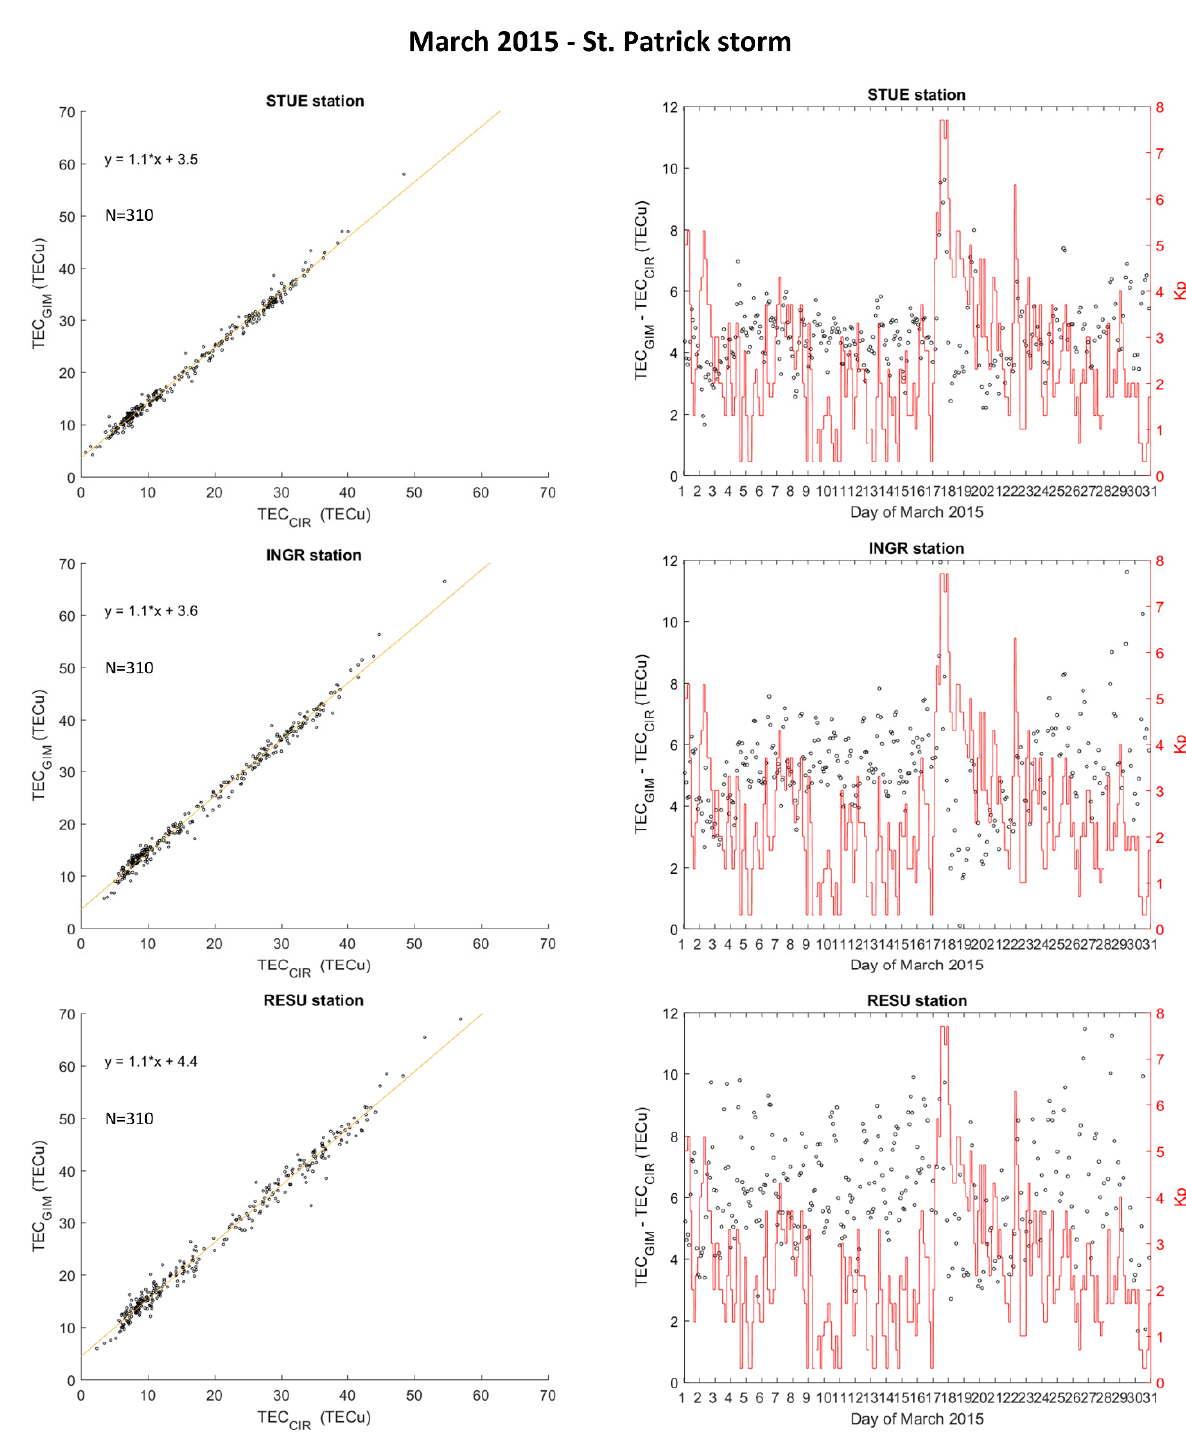
Figure 9. Scatterplots (TEC GIM vs. TEC CIR ) (left panels) and difference (TEC GIM –TEC CIR ) (right panels) for the whole month of March 2015, for STUE (upper row), INGR (middle row) and RESU (lower row). The number of considered measurements N is shown inside each of the left plots. K p values are plotted in red for the whole month in each of the right panels.